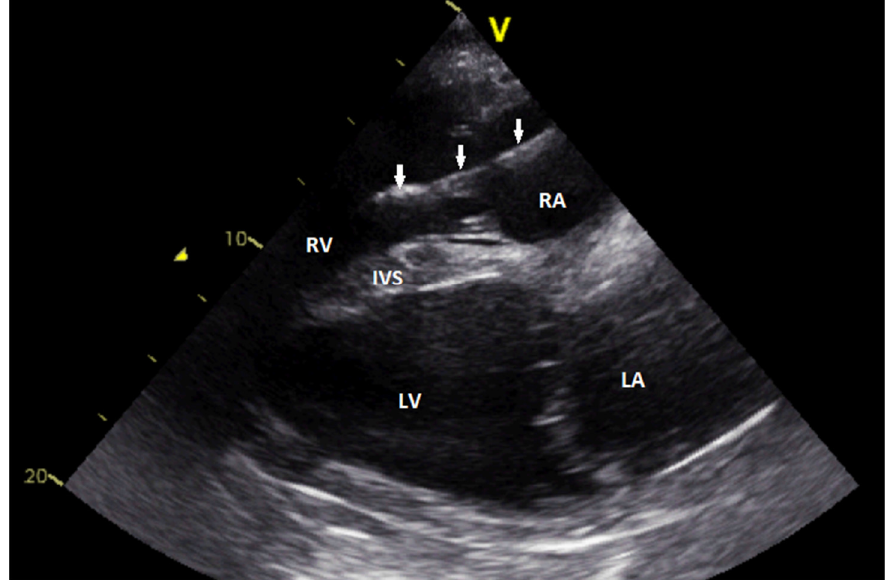
Figure 2. Echocardiographic image showing the right parasternal long-axis view. The lead (arrows) is visible in the right atrium and the right ventricle. The intraventricular part of the lead body shows slightly irregular surface (RA—rig ht atrium; RV—right ventricle; IVS—interventricular septum; LA—left atrium; LV—left ventricle).